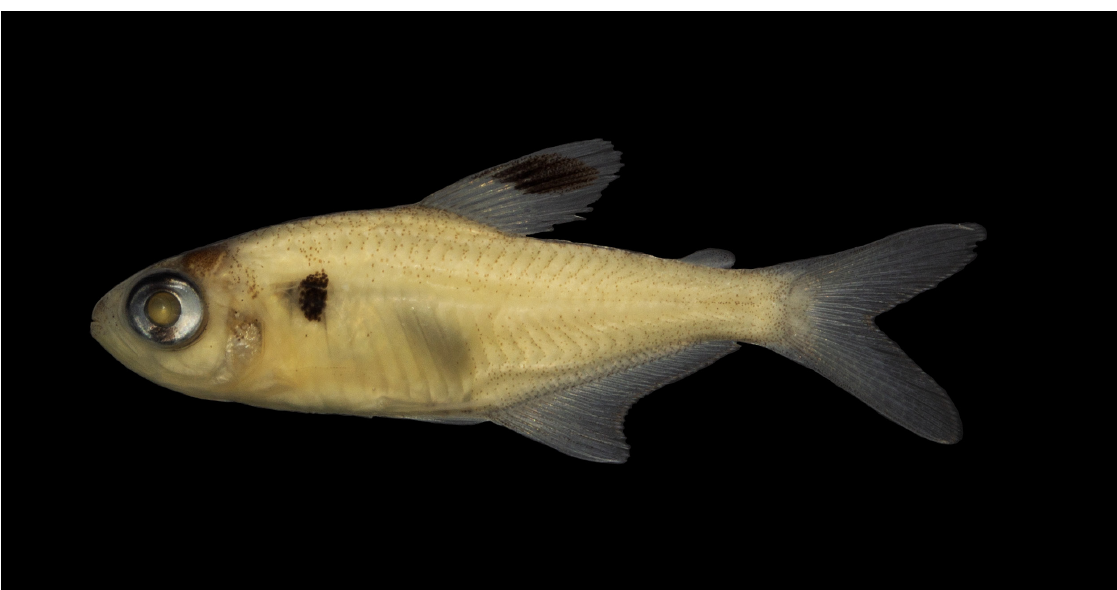
Fig. 1. Hyphessobrycon frickei Guimarães, Brito, Bragança, Katz & Ottoni sp. nov . , holotype (CICCAA 02363), 18.8 mm SL; Brazil: Maranhão State: Maracaçumé River basin.